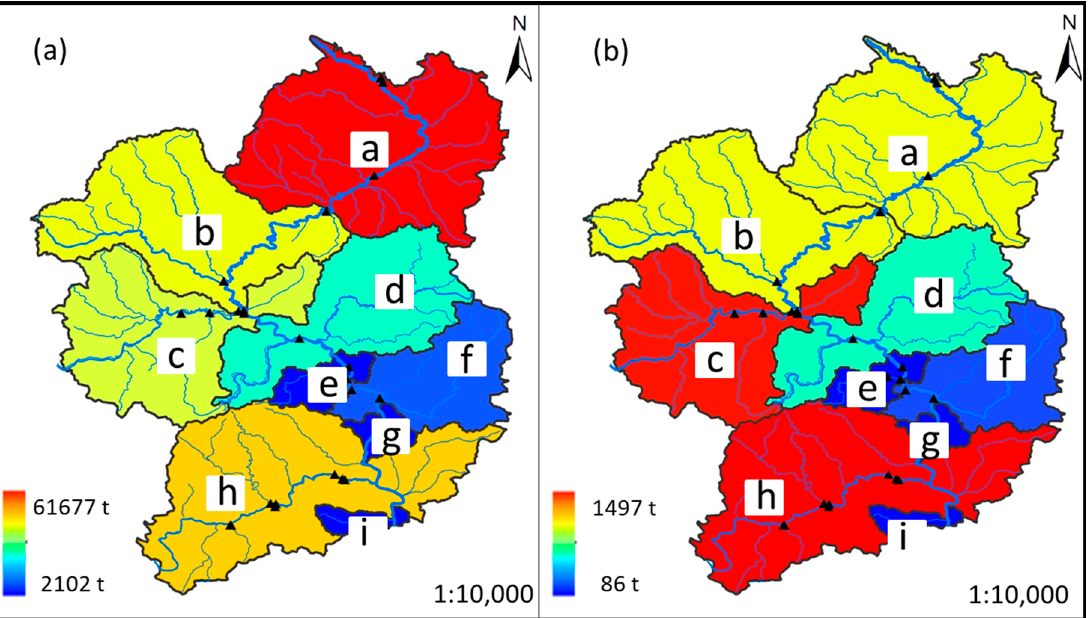
Figure 8. Pollutant output distribution in water function zones in 2015. ( a ) Chemical oxygen demand; ( b ) ammonia nitrogen.